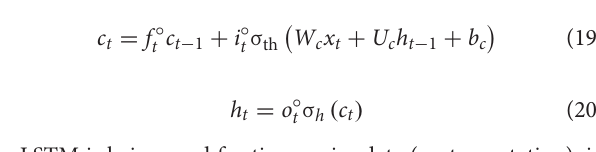
connections of input, output, and forget gates,